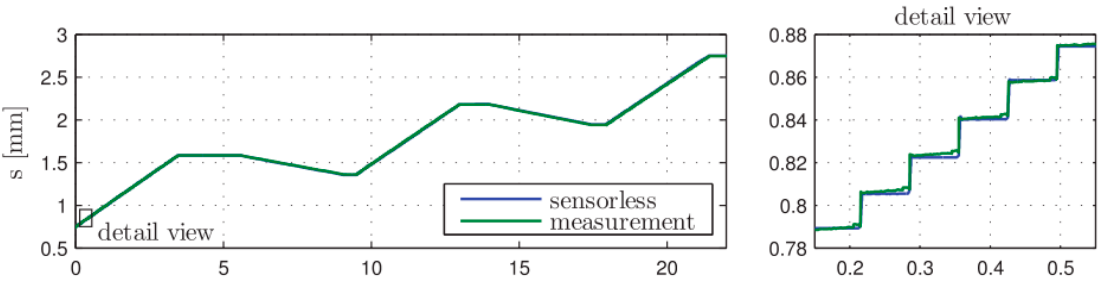
Figure 5. Experimental results of stepping drive in reference [25].